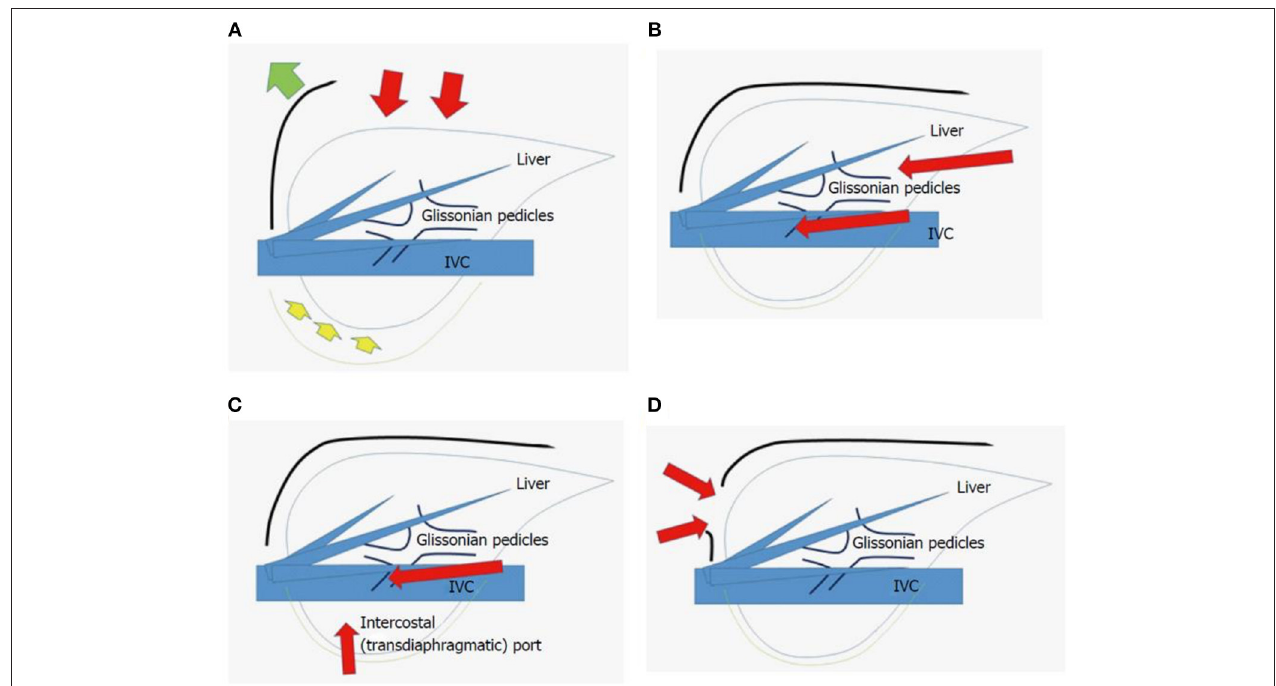
FIGURE 6 | Scheme of open liver resection (A) , laparoscopic liver resection [regular caudal approach, (B) ], laparoscopic liver resection [lateral approach, (C) ] and thoracoscopic liver resection (D) . Red arrows indicate the directions of view and manipulation in each approach. (A) In the open approach, the subcostal cage containing the liver is opened with a large subcostal incision and instruments are used to lift the costal arch, after which the liver is dissected and mobilized (lifted) from the retroperitoneum; (B) In the regular laparoscopic caudal approach, the laparoscope and forceps are placed into the subcostal cage from the caudal direction, and the surgery is performed with minimal alteration and destruction of the associated structures; (C) In the laparoscopic lateral approach, the intercostal (transdiaphragmatic) ports combined with total mobilization of the liver from the retroperitoneum can allow the direct lateral approach into the cage and to the posterosuperior tumors; (D) Thoracoscopic approach is employed for lesions in segment 8, with direct exposure of the tumor into the pleural cavity upon incision on the diaphragm adjacent to the tumor, with the endoscope placed in the pleural cavity. From Morise and Wakabayashi (